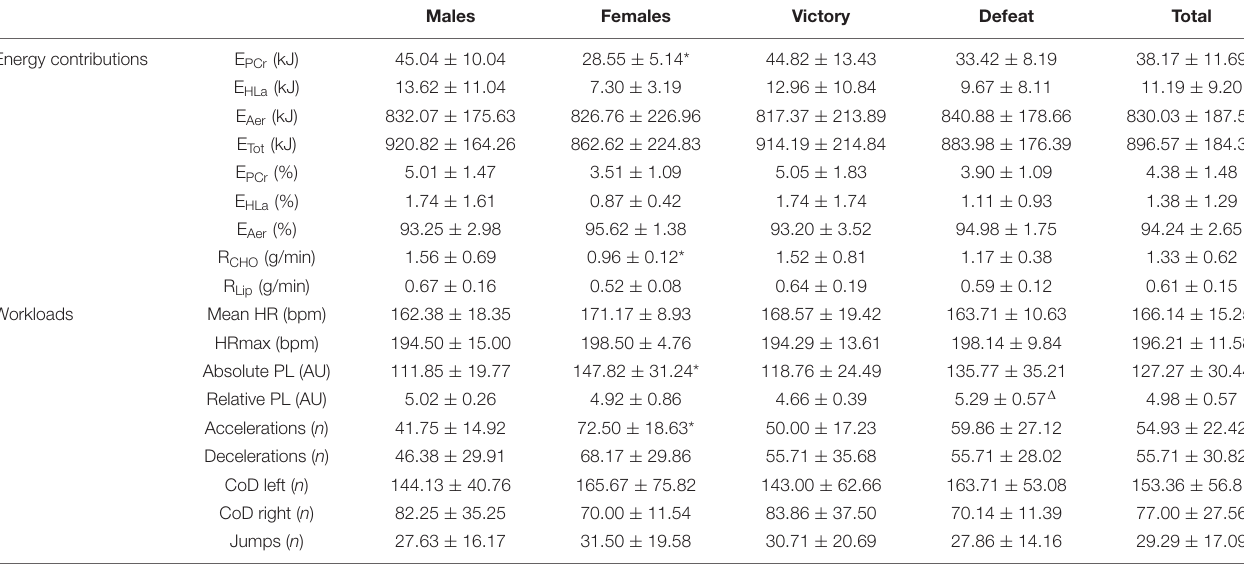
TABLE 2 | Descriptive results of energy contributions and workloads during a badminton match. Males Females Victory Defeat